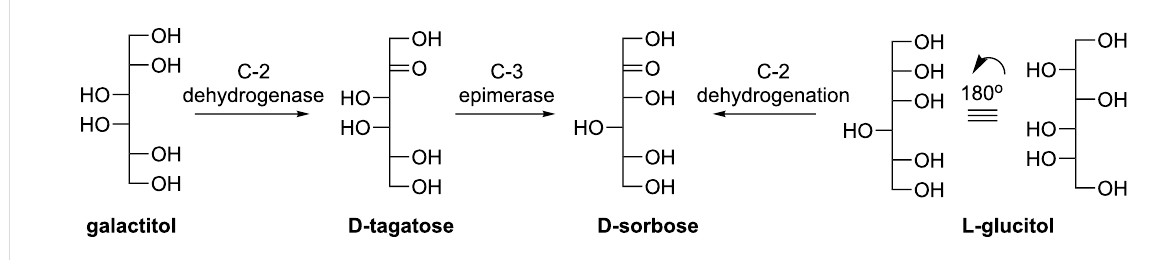
Scheme 4: Proposed pathway of the D-sorbose synthesis from galactitol or L-glucitol.